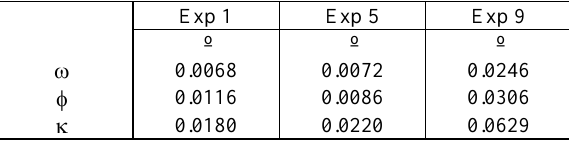
Table 7 – Estimated average standard deviation for the attitude parameters.